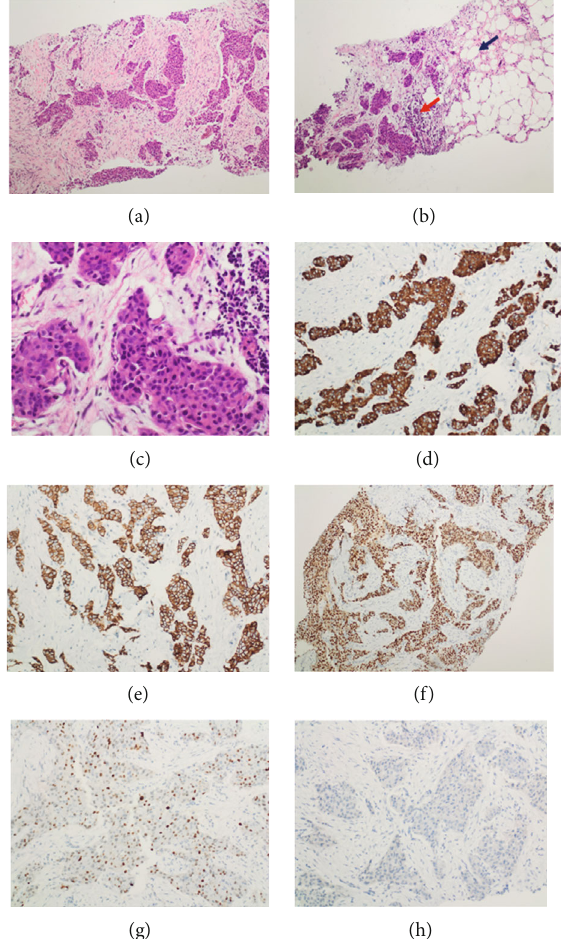
Figure 7: Histopathology and immunology of the needle core biopsy of the malignant tumor. (a) Biopsy tissue showed invasive ductal carcinoma forming solid sheets and nests of tumor cells surrounded by desmoplastic stroma, H and E, × 100. (b) Nests of tumor cells in fi ltrating adjacent fatty tissue (black arrow). Note the stromal lymphocytic in fi ltrate (red arrow), H and E, × 100. (c) High-power view revealed tumor cells with intermediate-grade nuclei, H and E, × 400. (d) Pancytokeratin is strongly positive in tumor cells. (e) E-cadherin stain showed strong di ff use membranous positivity, × 200. (f) ER showed strong nuclear positivity in more than 90% of tumor cells, × 200. (g) PR showed positive nuclear staining in around 30% of tumor cells, × 200. (h) HER-2 is completely negative, ×